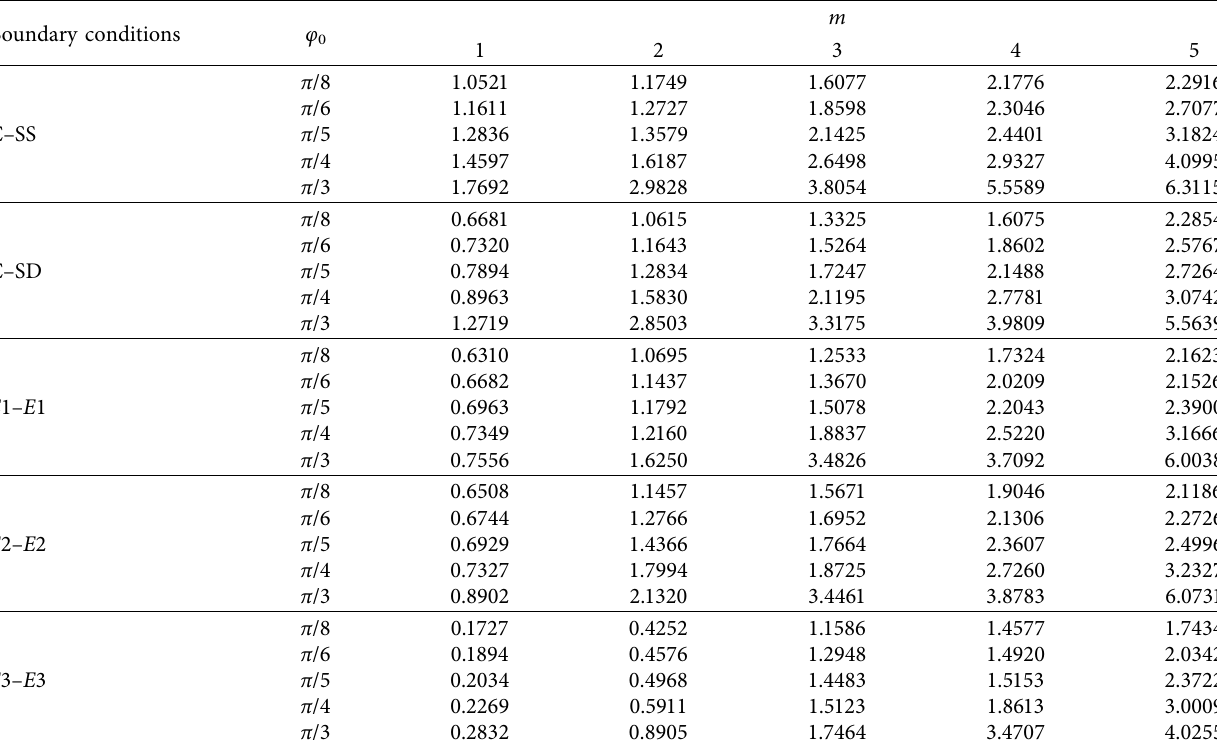
Table 9: Results of annular spherical shell with different φ